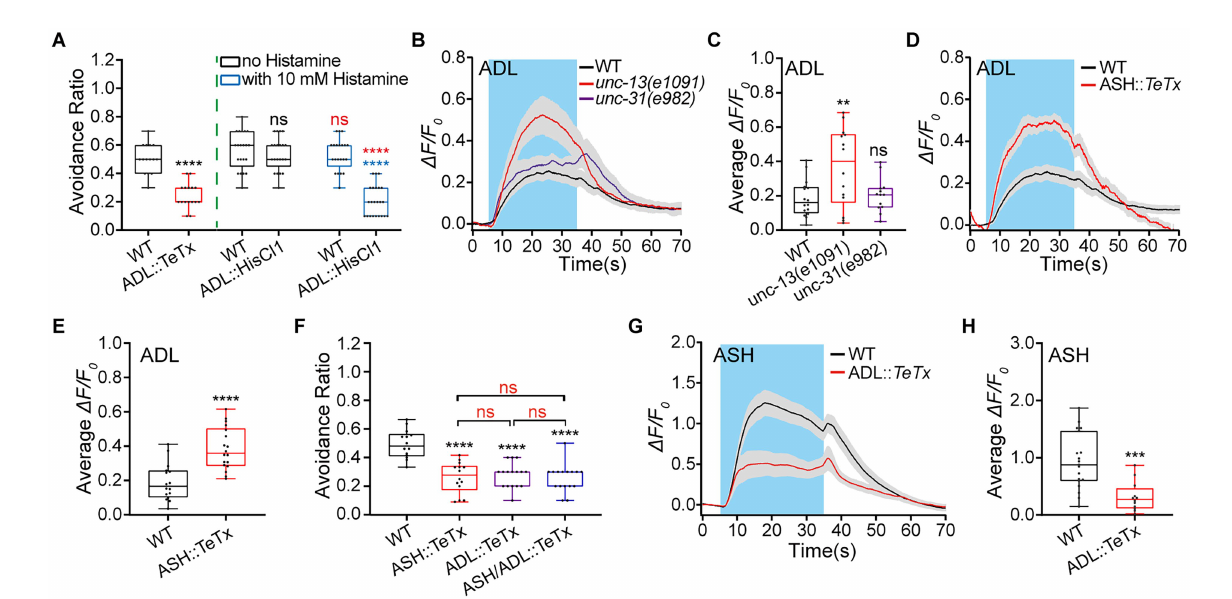
FIGURE 1 Interaction between ADL and ASH sensory neurons is required for normal avoidance of hyperosmolality in C. elegans . (A) The percentage or ratio of avoidance of a droplet of hyperosmolality by 0.88 Osm glycerol/M13 solution in wild-type (WT) N2 as control, ADL:: TeTx, and ADL:: hisCl1 transgenic animals treated with or without 10 mM histamine. (B–E) The somal calcium signals in paired ADL sensory neurons in response to the hyperosmolality in WT, mutant, and transgenic animals of indicated genotypes. (B,D) Curves of Ca 2+ transients presented as means (solid traces) ± SEM (gray shading) with cerulean background indicating the application of 0.88 Osm glycerol/M13 solution; (C,E) Box plots of the average intensity of Ca 2+ signals of the ON response during glycerol/M13 solution perfusion with each dot representing the data from each individual tested animal. (F) Ratio of avoidance of the droplet of the hyperosmotic solution in the WT N2 and transgenic animals. (G,H) The somal calcium signals in ASH in response to the hyperosmolality in WT and ADL:: TeTx transgenic worms. G, curves of Ca 2+ transients presented as means (solid traces) ± SEM (gray shading) with cerulean background indicating the application of 0.88 Osm glycerol/M13 solution; H, box plots of the average intensity of Ca 2+ transients of the ON response during glycerol/M13 solution perfusion with each dot representing the data from each tested animal. Heat maps of Ca 2+ signals are shown in Supplementary Figure S1. Statistical significance is indicated as and in different colors: ns, not significant, ** p < 0.01, *** p < 0.001, and **** p < 0.0001; black, the tested vs. the WT; red, the histamine treated vs. the histamine untreated of the same genotype (in A ) or as indicated (in F ); blue, the tested vs. WT under histamine treatment (in A